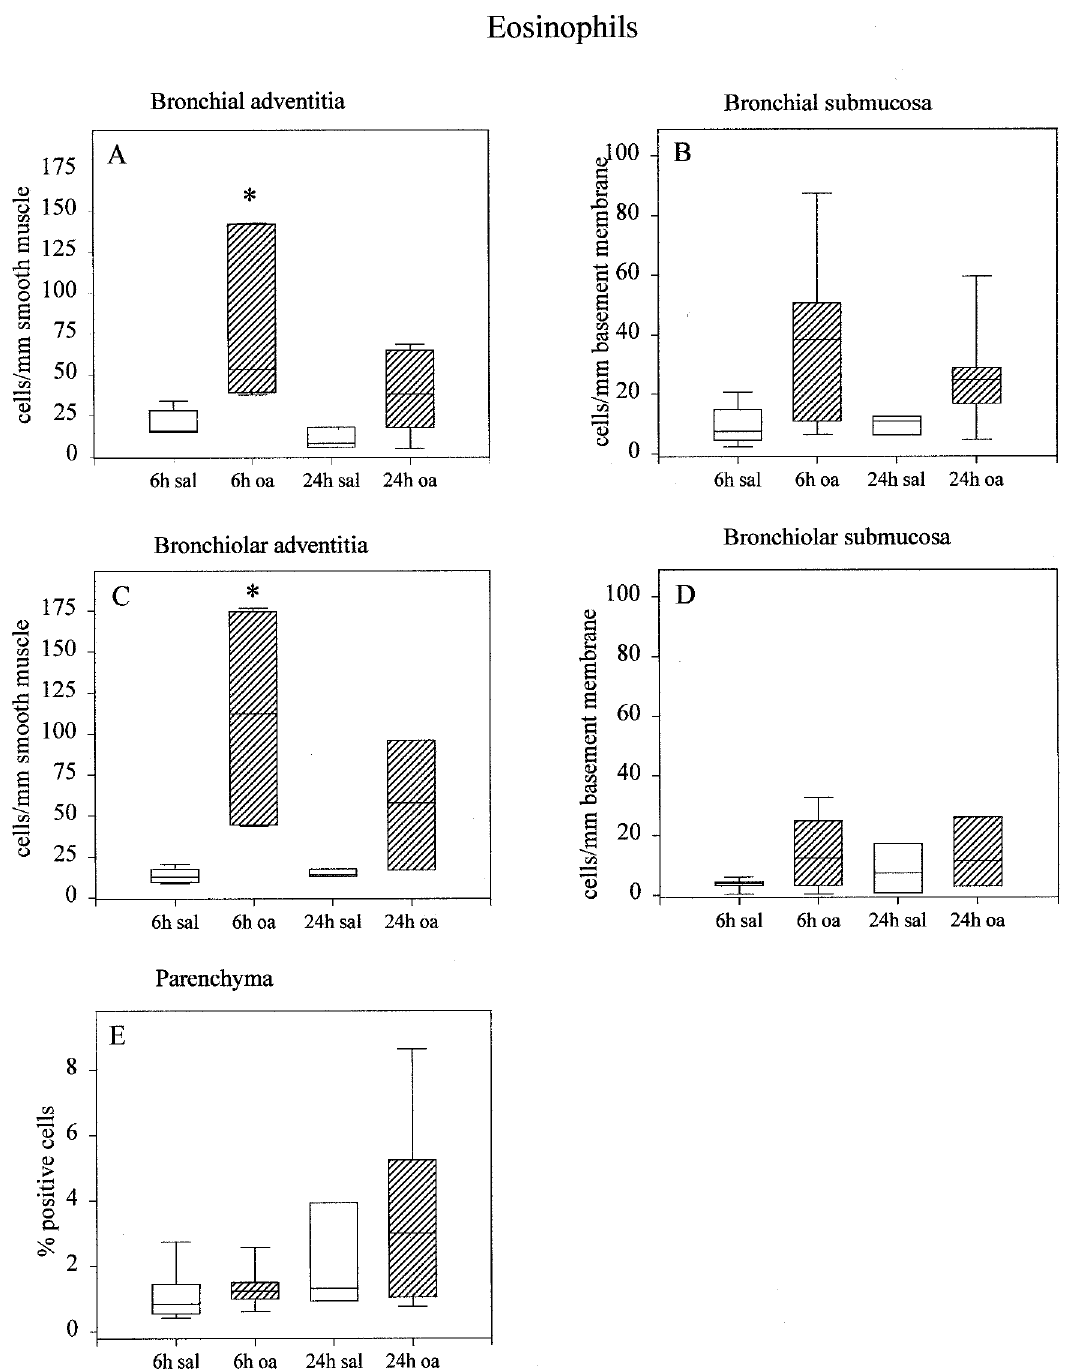
FIG. 3. Eosinophil numbers at 6 and 24h after saline control inhalation (sal, open bars) or ovalbumin inhalation (oa, hatched bars) in different airway compartments. Data represent median values, interquartiles, and 10th and 90th percentiles of four to six animals. Statistical analysis: * p < 0.01, Mann–Whitney rank sum